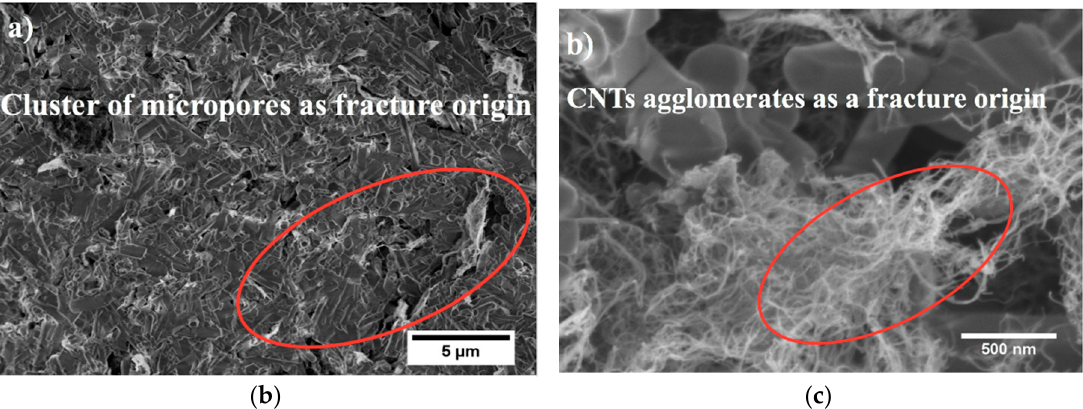
Figure 8. Fracture origins of 3 wt.% MWCNT-reinforced Si 3 N 4 : ( a ) area with micropores ( b ) large agglomerate of MWCNTs. (Authors’work)